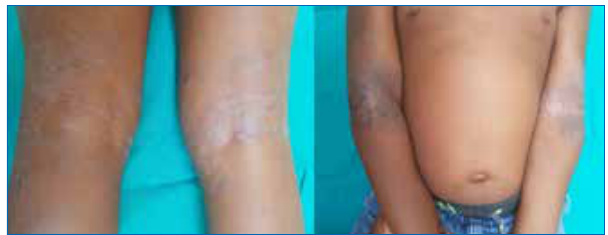
Figure 7: Atopic dermatitis on flexor aspect of limbs